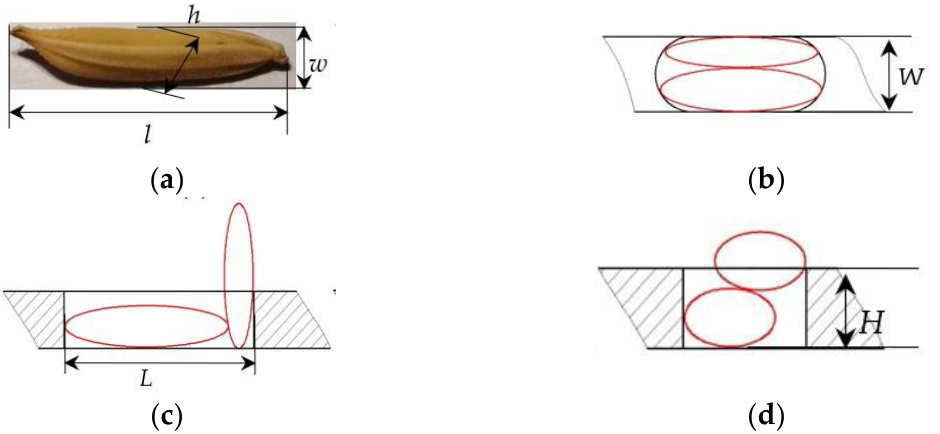
Figure 5. Schematic diagram of the seed and limit dimension of the hole: ( a ) 3-D seed size; ( b ) Limited width of the shaped hole; ( c ) Limited length of the shaped hole; ( d ) Limited height of the shaped hole.